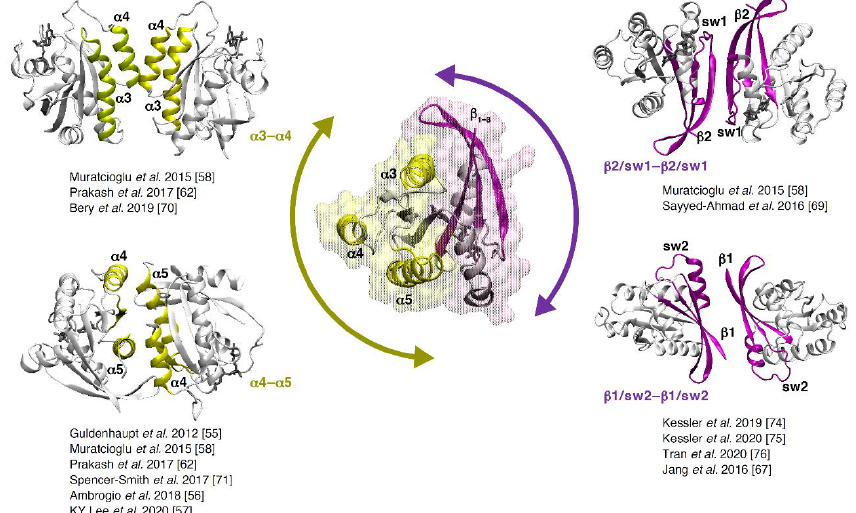
Figure 6C–E adapted with permission from [53] (Proc. Nat.l Acad. Sc.i USA 2015, 112 (26), 7996–8001). Copyright (2015) National Academy of Sciences, USA. Figure 6F,G adapted from [56] (Cell 2018, 172